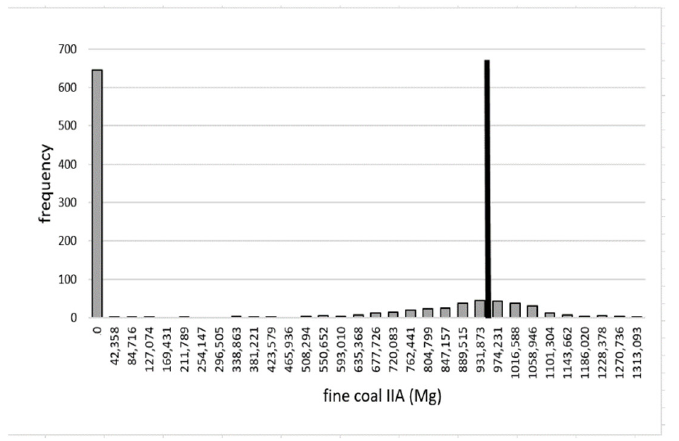
Figure A24. Histogram showing frequencies of achieving given quantity of sales of fine coal IIA (“Export 9”) for mine “G” with σ yprog .